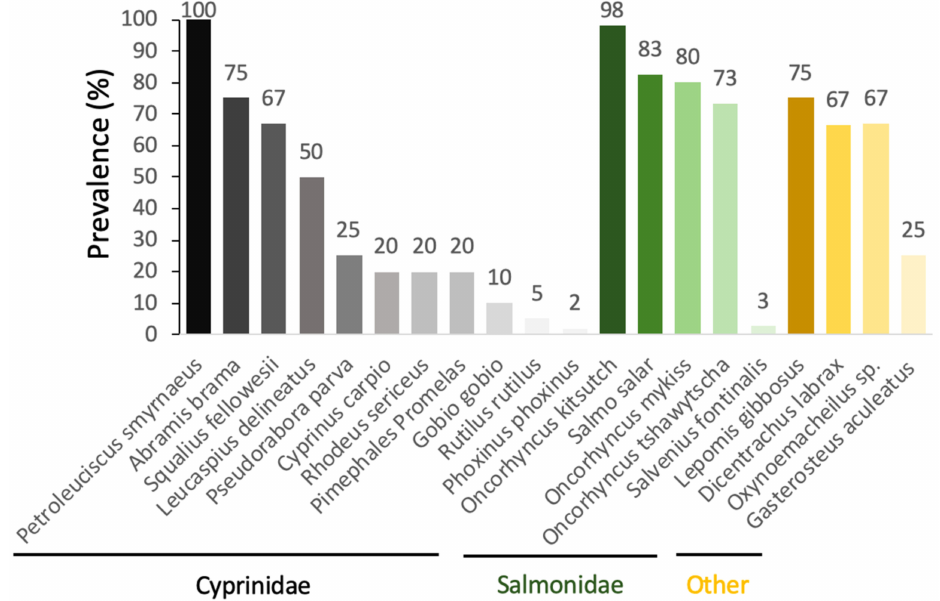
Figure 4. Prevalence of the rosette agent Sphareothecum destruens detected by PCR in different species of wild and aquacultured